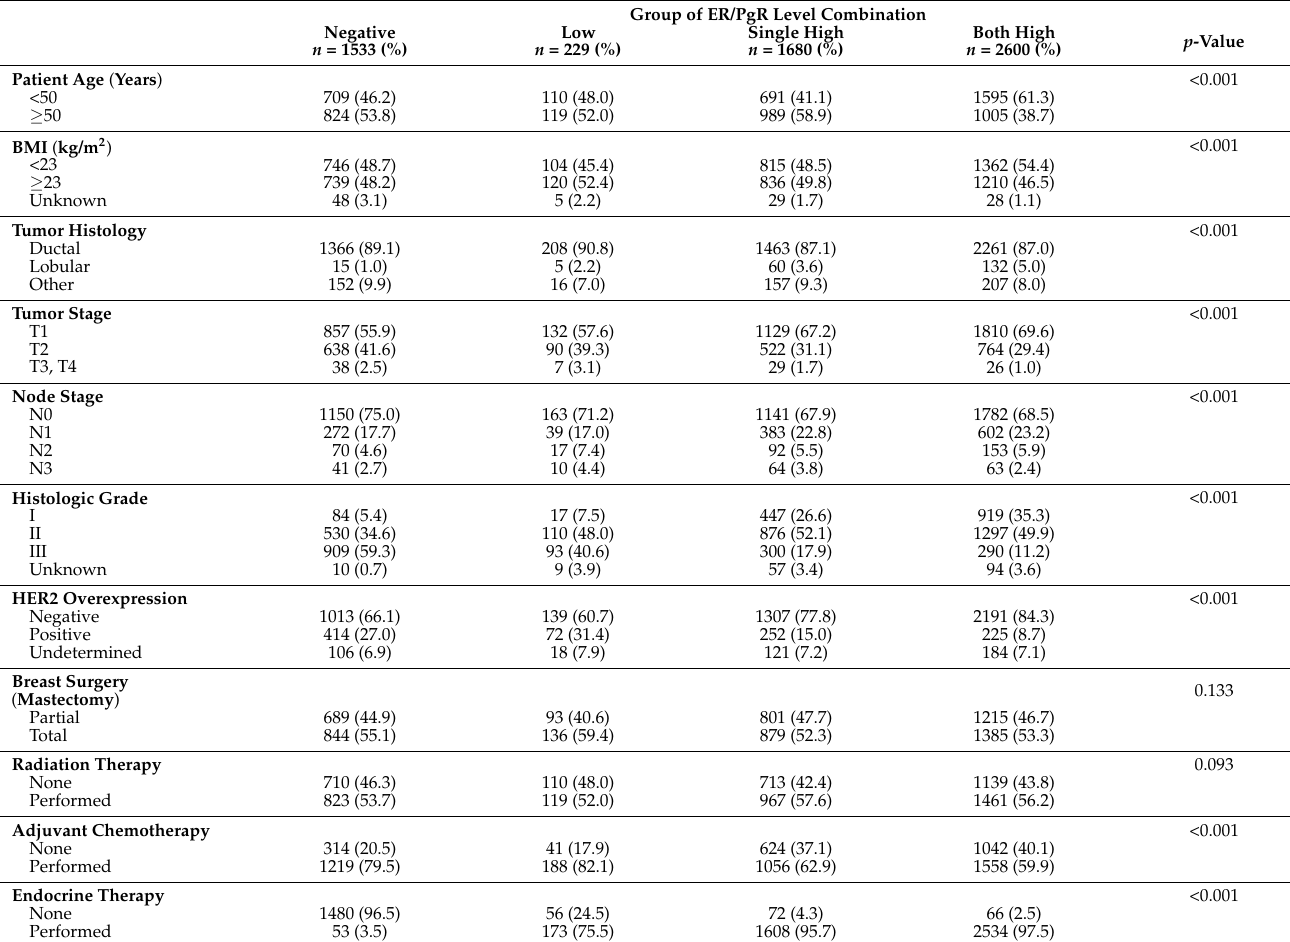
Table 1. Baseline characteristics of patients classified according to the groups of hormone receptor levels.